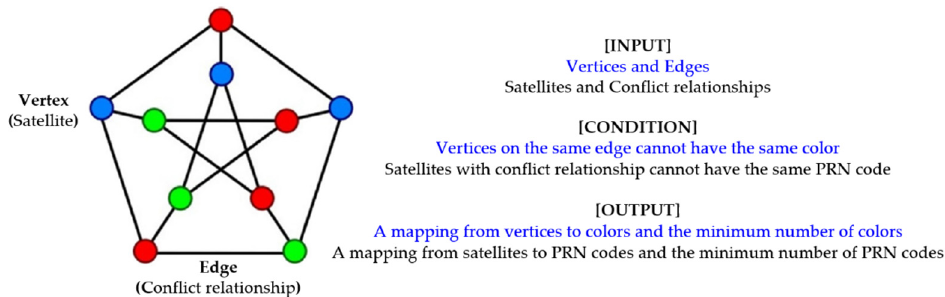
Figure 3. The consistency description of the two problems from the perspective of input, condition and output. The graph on the right is a model of graph coloring problem. The description of the graph coloring problem is in blue, and the description of the satellite PRN code assignment problem is in black.